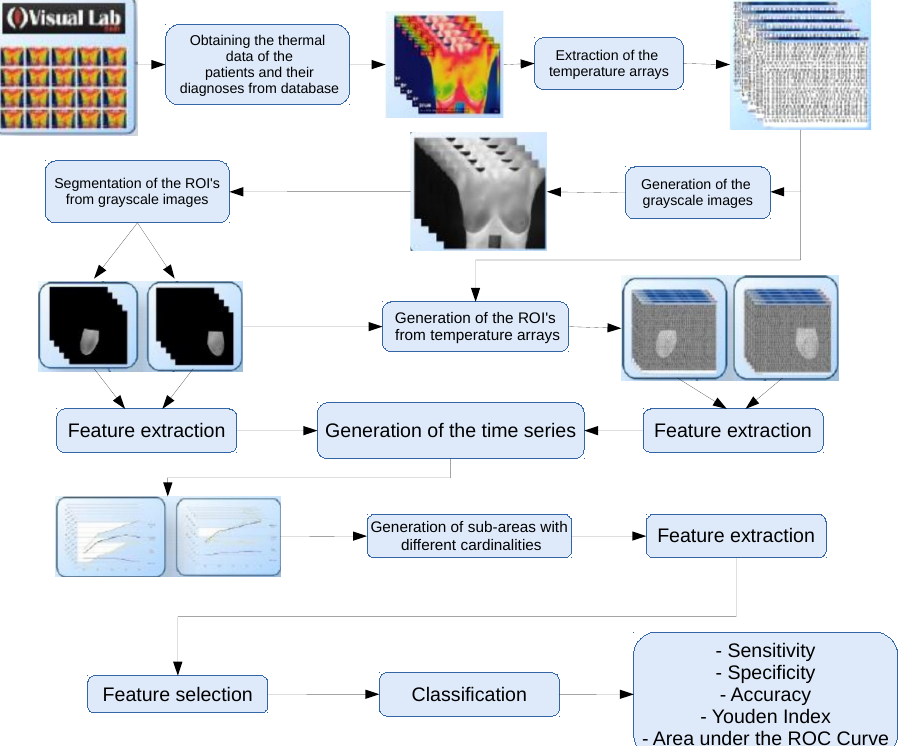
Figure 2. Flowchart of the proposed